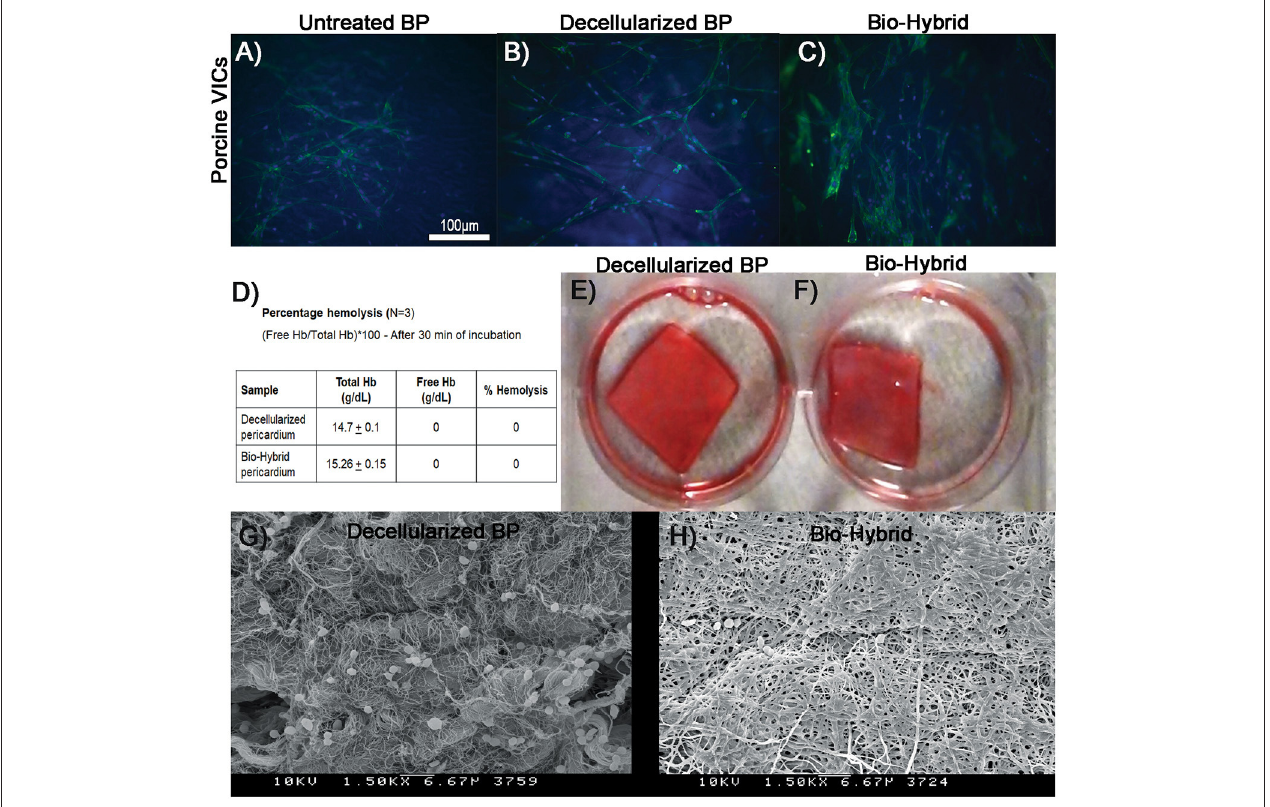
FIGURE 7 | In-vitro biocompatibility and hemocompatibility studies of the decellularized BP and the biohybrid composite. (A–C) In-vitro biocompatibility of the untreated glutaraldehyde-fixed BP, decellularized BP, and the biohybrid by cell adhesion assay. Cell adhesion of porcine valve interstitial cells showing good attachment on the decellularized BP and the biohybrid samples compared to untreated glutaraldehyde-fixed BP, (D) percentage hemolysis of cells on the decellularized BP and the biohybrid showing no hemolysis on both the samples when incubated with fresh porcine blood for 30min, (E,F) clot formation assay showing no clots on both the decellularized BP and the biohybrid samples after 30min of incubation with blood, and (G,H) SEM images of the decellularized BP and the biohybrid incubated with platelets showing very minimal platelet adhesion on the biohybrid compared to the decellularized